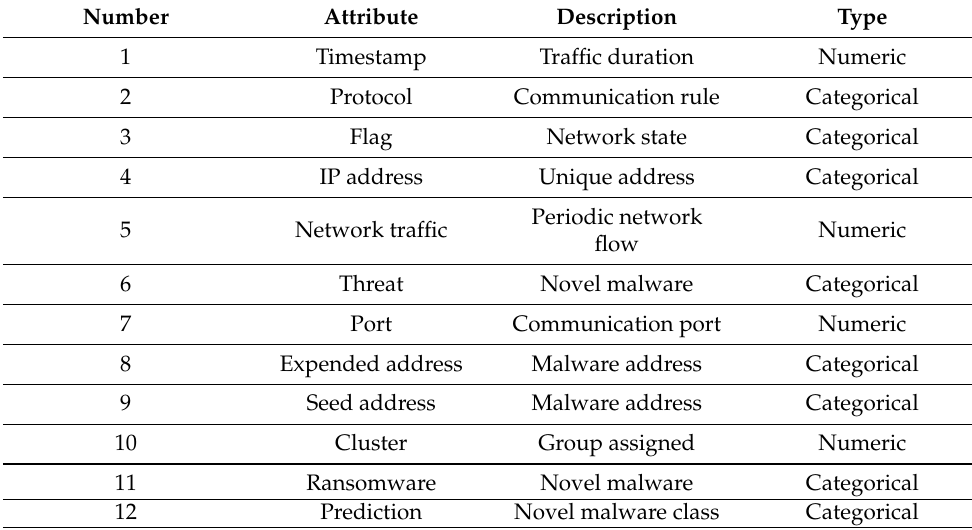
Table 5. Extracted UGRansome features.